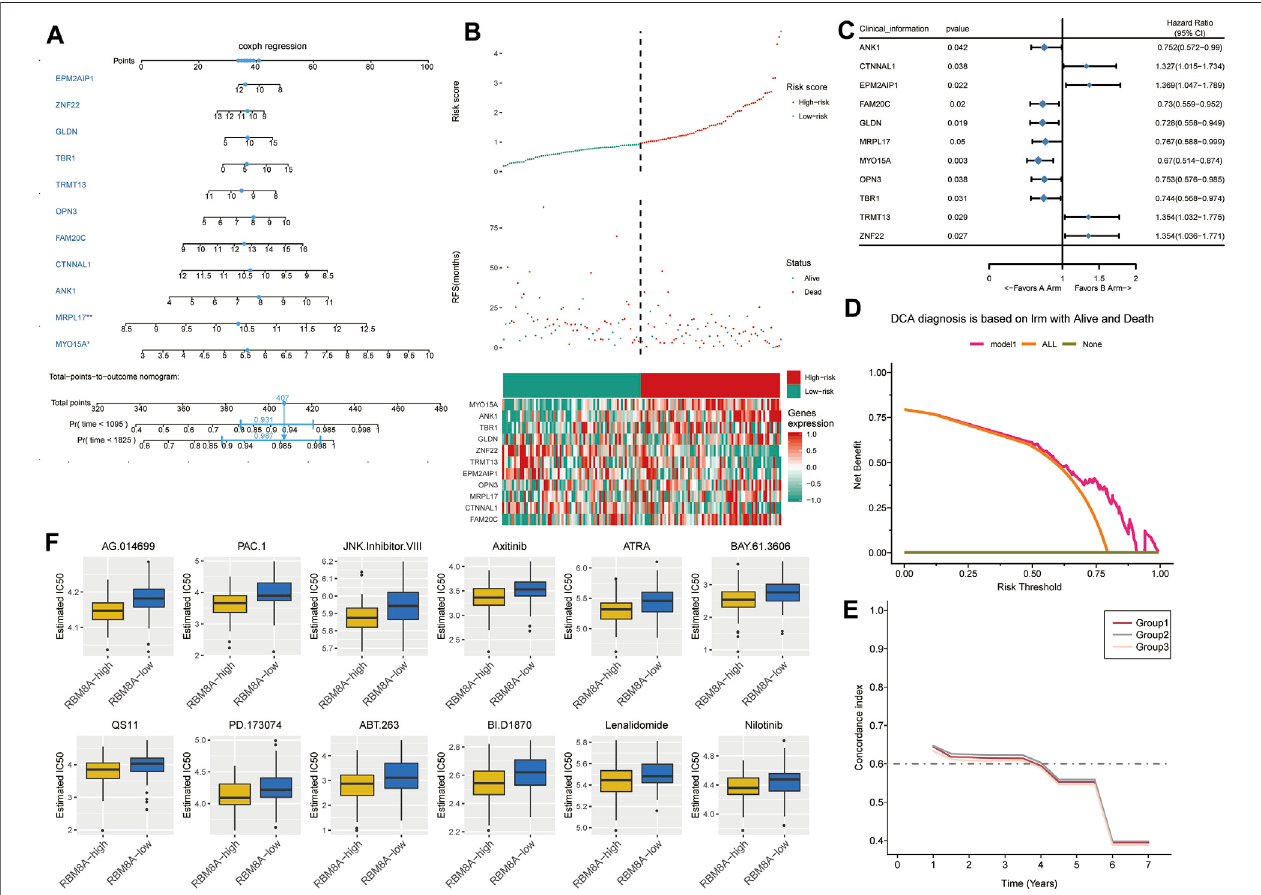
FIGURE7| ThesurvivalpredictionmodelforGBMbasedoncandidatemRNAs. (A) AnomogrampredictionmodelwasconstructedbasedoncandidatemRNAsin TCGA. (B) Distribution of candidate mRNA-based risk scores, mRNA expression levels, and patient survival in TCGA. (C) Forest plots of Cox regression analysis of candidatemRNAs. (D) Decisioncurve analysisofcandidatemRNAsforpredicting survivalstatus. (E) C-indexcomparisonamonggroup1(allcandidatemRNAs), group 2 [candidate mRNAs with areas under the receiver operating characteristic curve (AUCs) > 0.5] and group 3 (candidate mRNAs with AUCs > 0.6). (F) Box plots to estimate IC 50 for chemotherapies to treat RBM8A high and RBM8A low